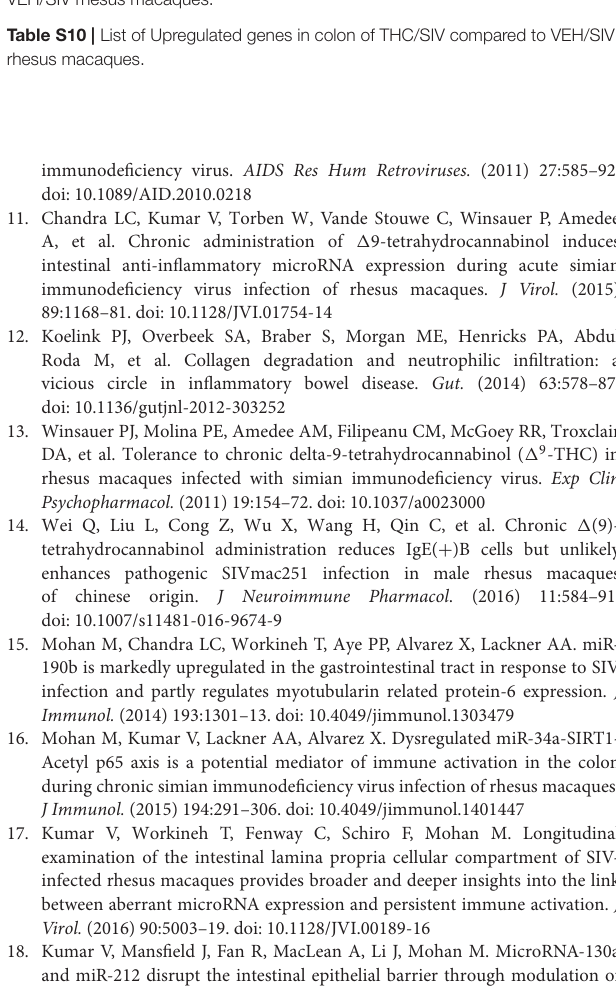
Table S1 | CD4 + T cells are significantly depleted in the intestines of both VEH/SIV and THC/SIV rhesus macaques during chronic SIV infection. Table shows CD4 + and CD8 + T cell percentages in the intestine at necropsy. Normal CD4 + T cell percentages in the intestine as shown in Figure 7C range from 30 to